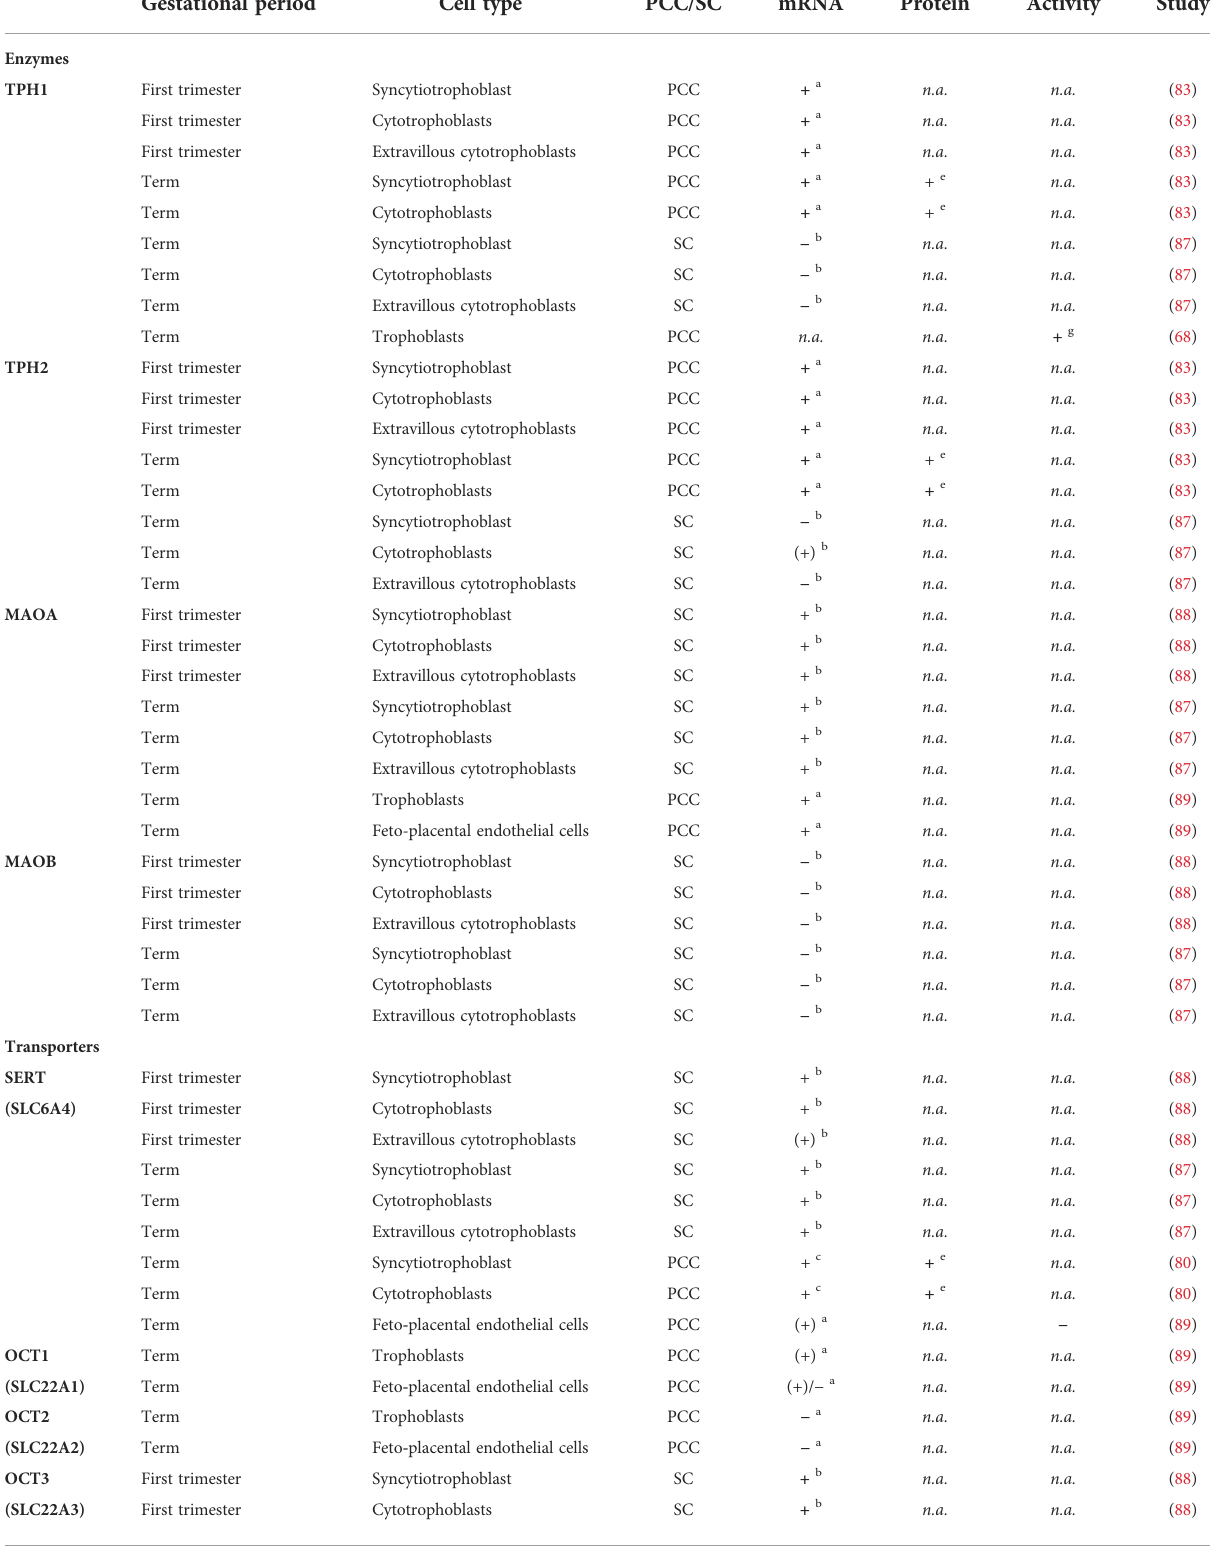
TABLE 3 Results on the presence of components of the serotonin system in human primary cell cultures (PCC) or single cells (SC). Gestational period Study